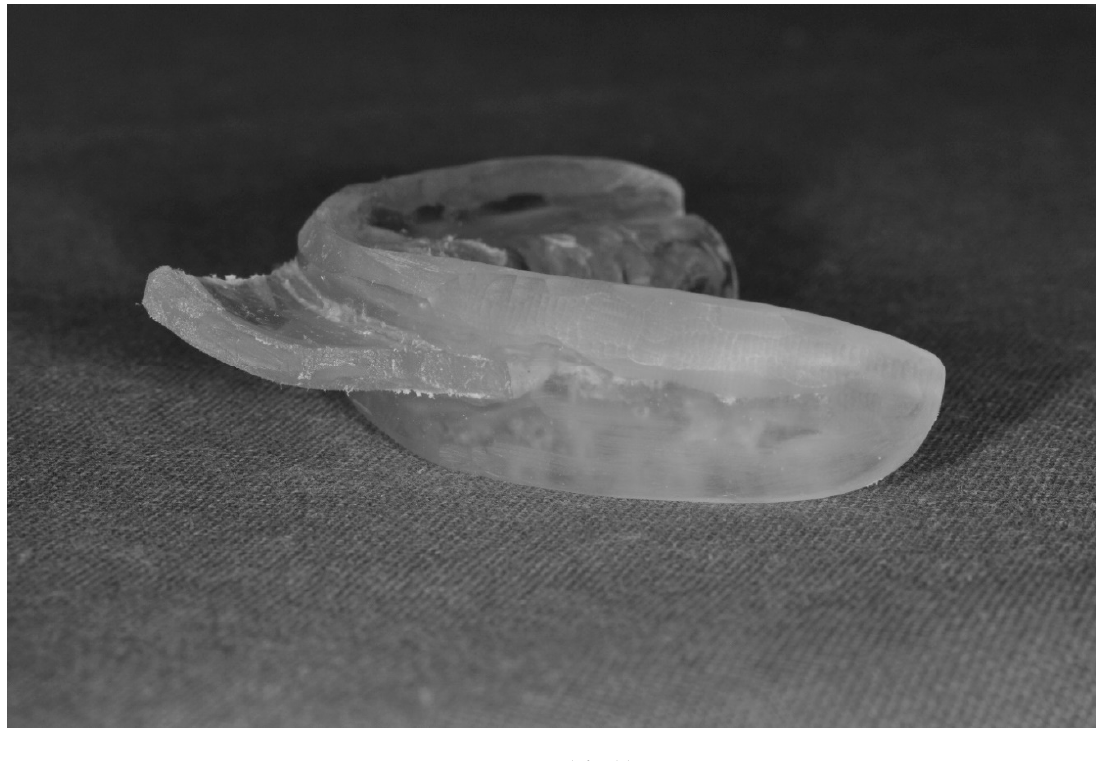
Figure 7. Modified bite.